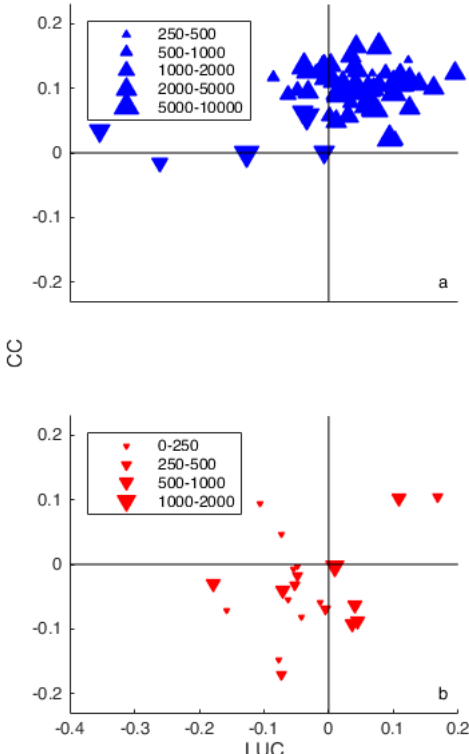
Figure 7. Contribution of land use change ( x -axis) and climate change ( y -axis) for ( a ) the American and ( b ) Australian catchments with a significant trend in discharge and significant LUC and / or CC values. The surface area of the catchments is indicated by the symbol sizes and shown in km 2 .